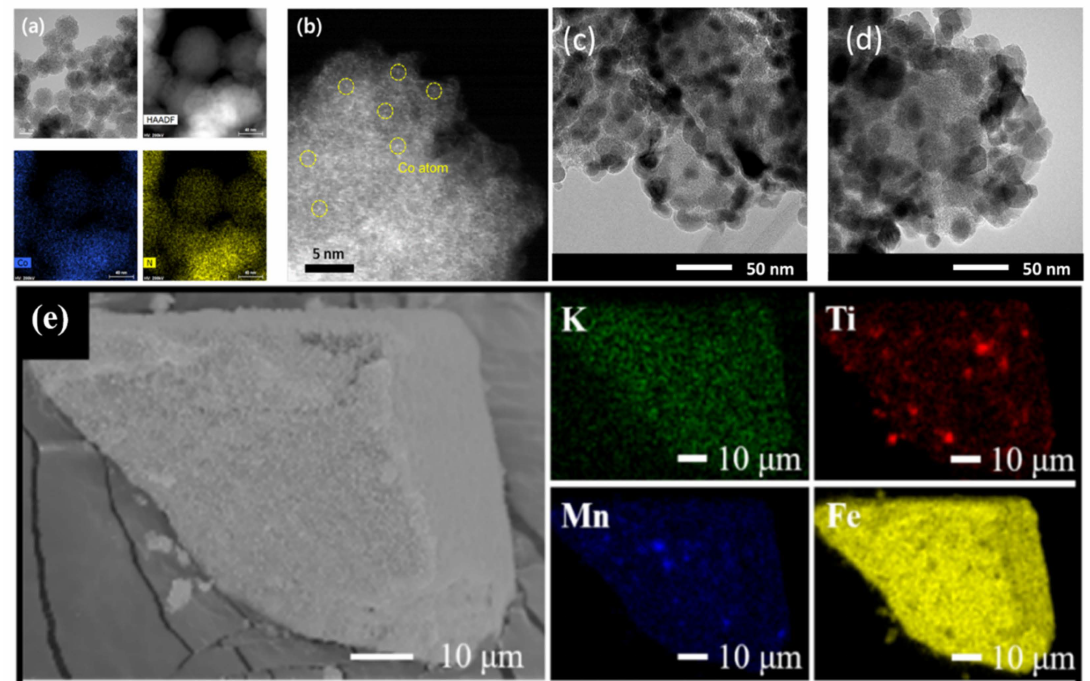
Figure 5. ( a ) TEM-EDS mapping images, ( b ) HADDF-STEM images of atomic Co incorporated in the matrix of Co–NC SAS acquired by Cs-STEM at a higher magnification. Reprinted with